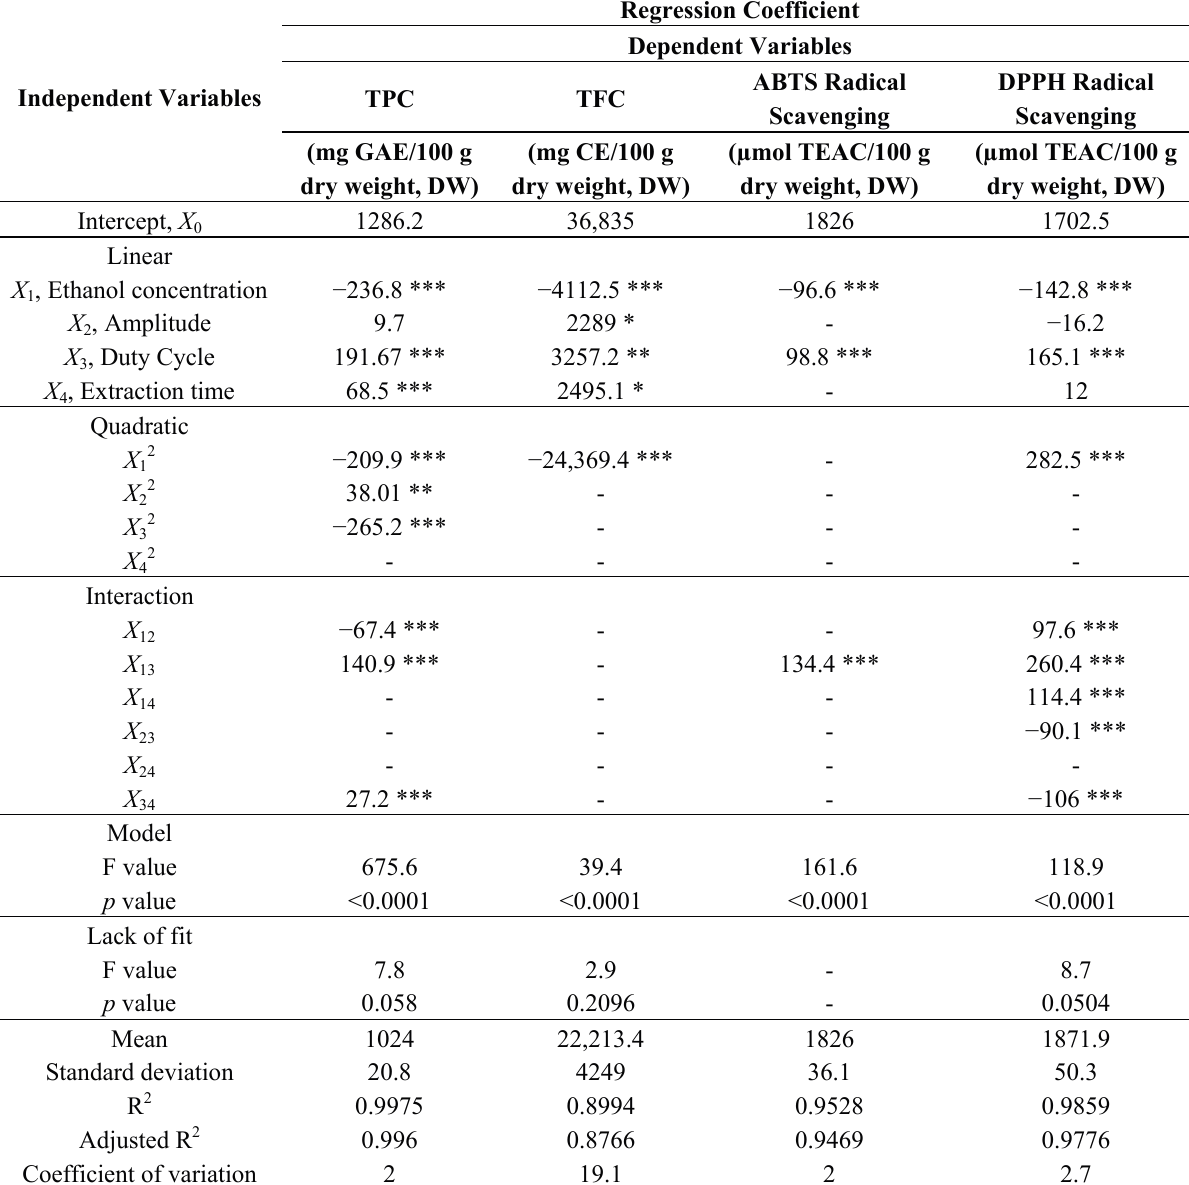
Table 2. Regression coefficients, R 2 , adjusted R 2 , lack of fit test and probability values for the reduced second-order polynomial models of four dependent variables of ultrasound-assisted Orthosiphon stamineus